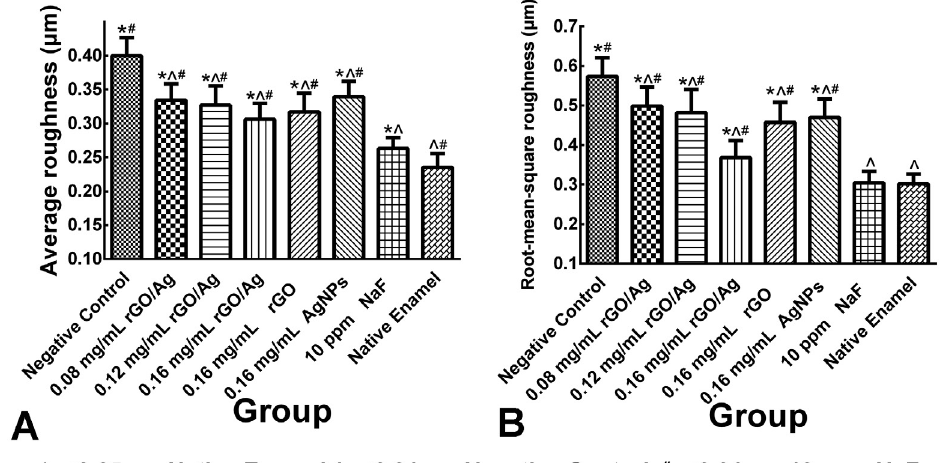
Figure 2- Graphical representation of the quantification results for enamel surface roughness of the teeth specimens in different treatment groups. (A) average roughness (Ra); (B) root-mean-square roughness (Rq). Ra and Rq values are expressed as mean±standard